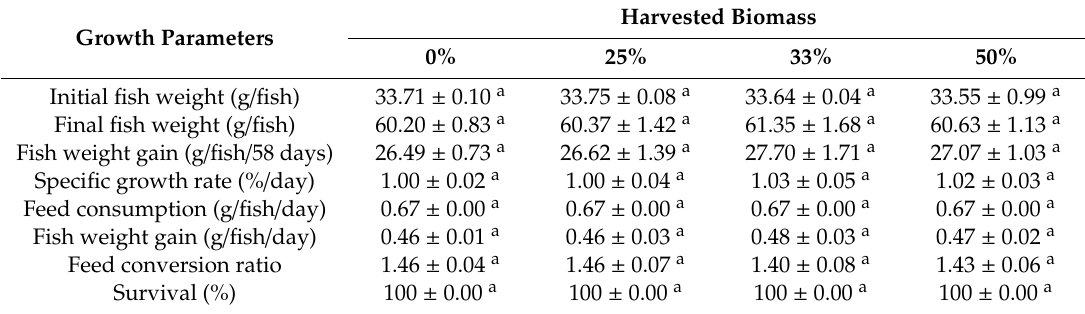
Table 3. Growth performance of Cyprinus carpio reared for 58 days in integrated recirculating aquaponic systems under di ff erent plant harvesting regimes.